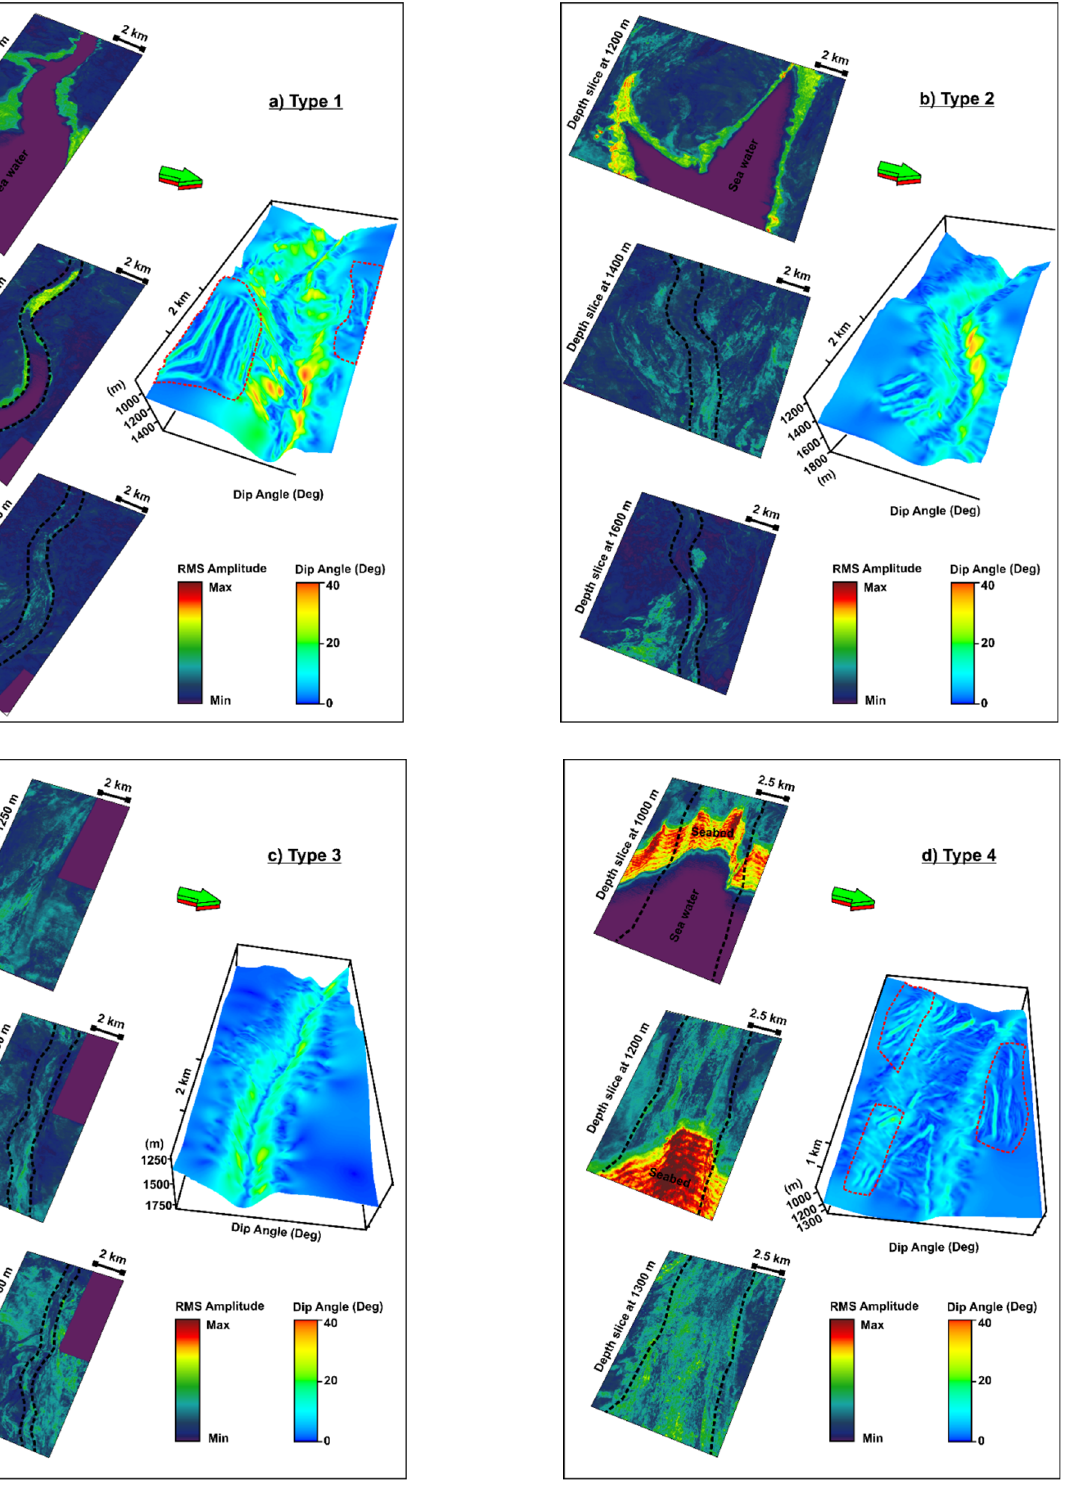
Figure 9. 3D view of dip angle (right images) and depth RMS Amplitude slice (left images) of ( a ) Type 1, ( b ) Type 2, ( c ) Type 3, and ( d ) Type 4 of channels complexes in this study. Dashed black and red lines represent channel outline and sediment waves, respectively. See Figure 4 for the channel’s location.